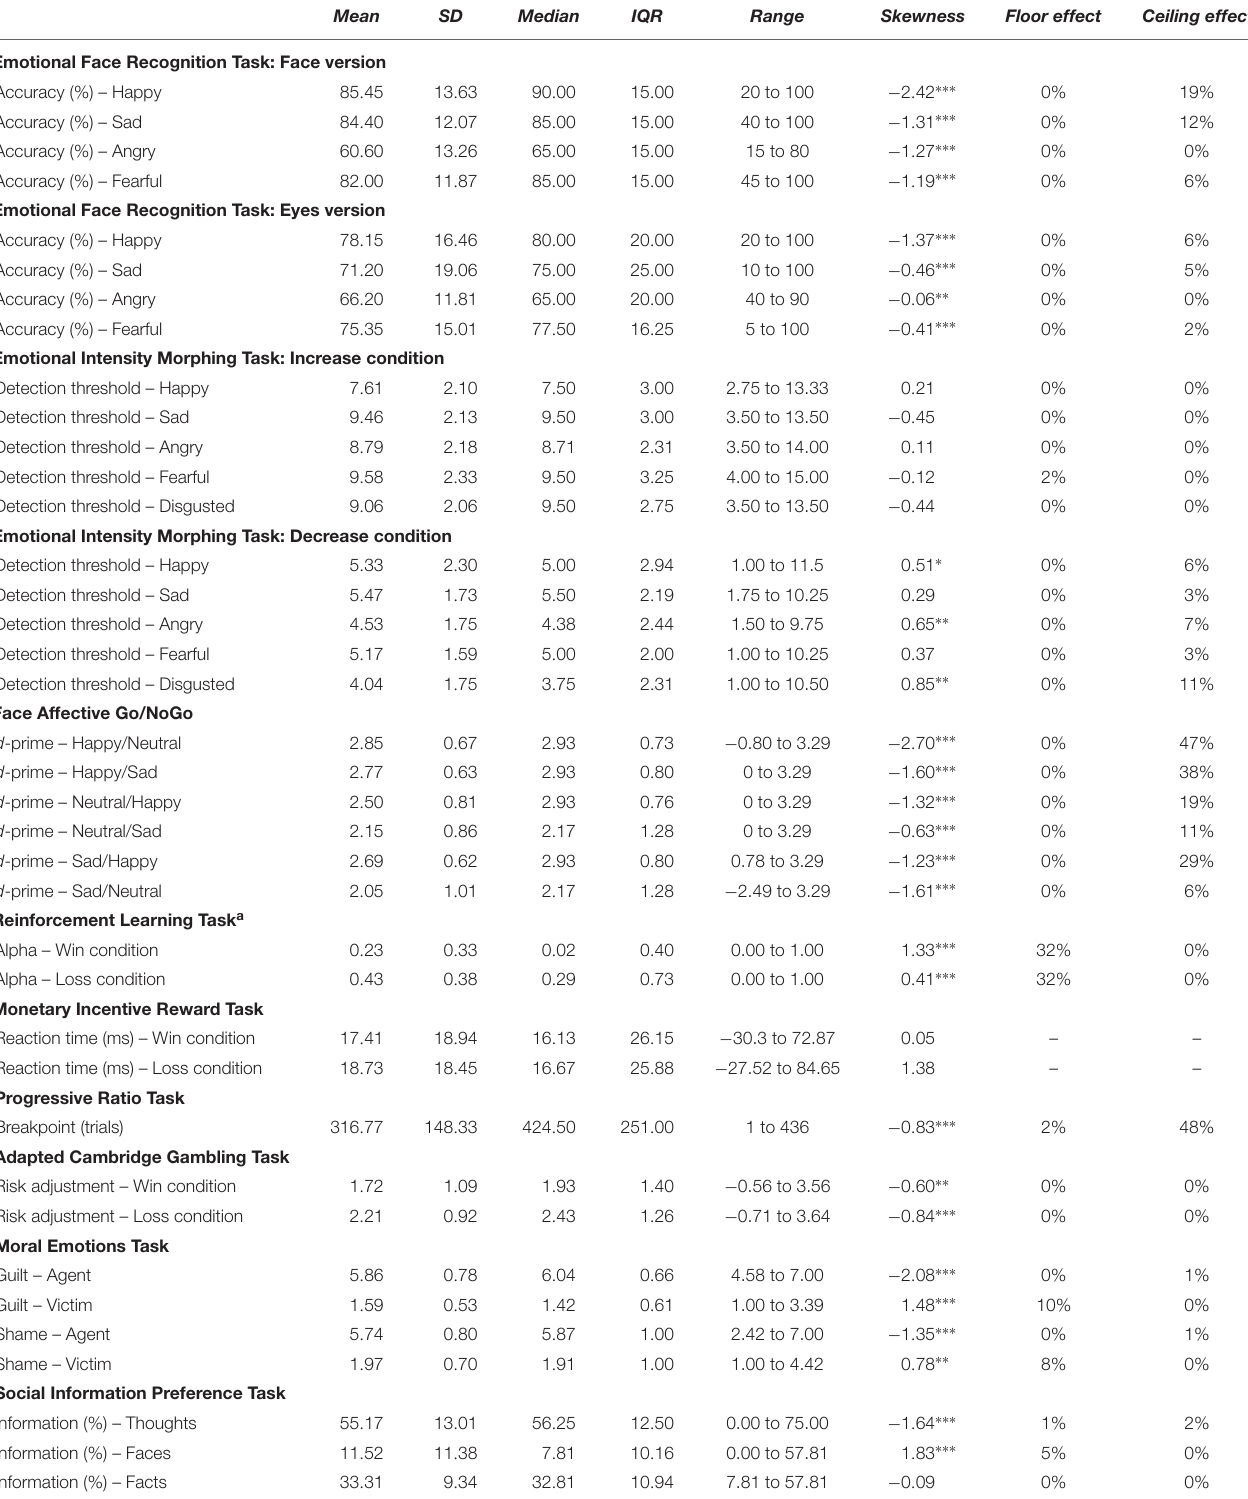
TABLE 3 | Primary